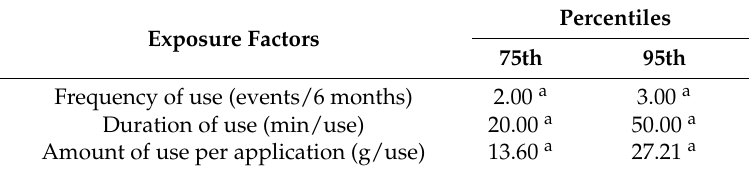
Table 2. Input parameters for exposure assessment.